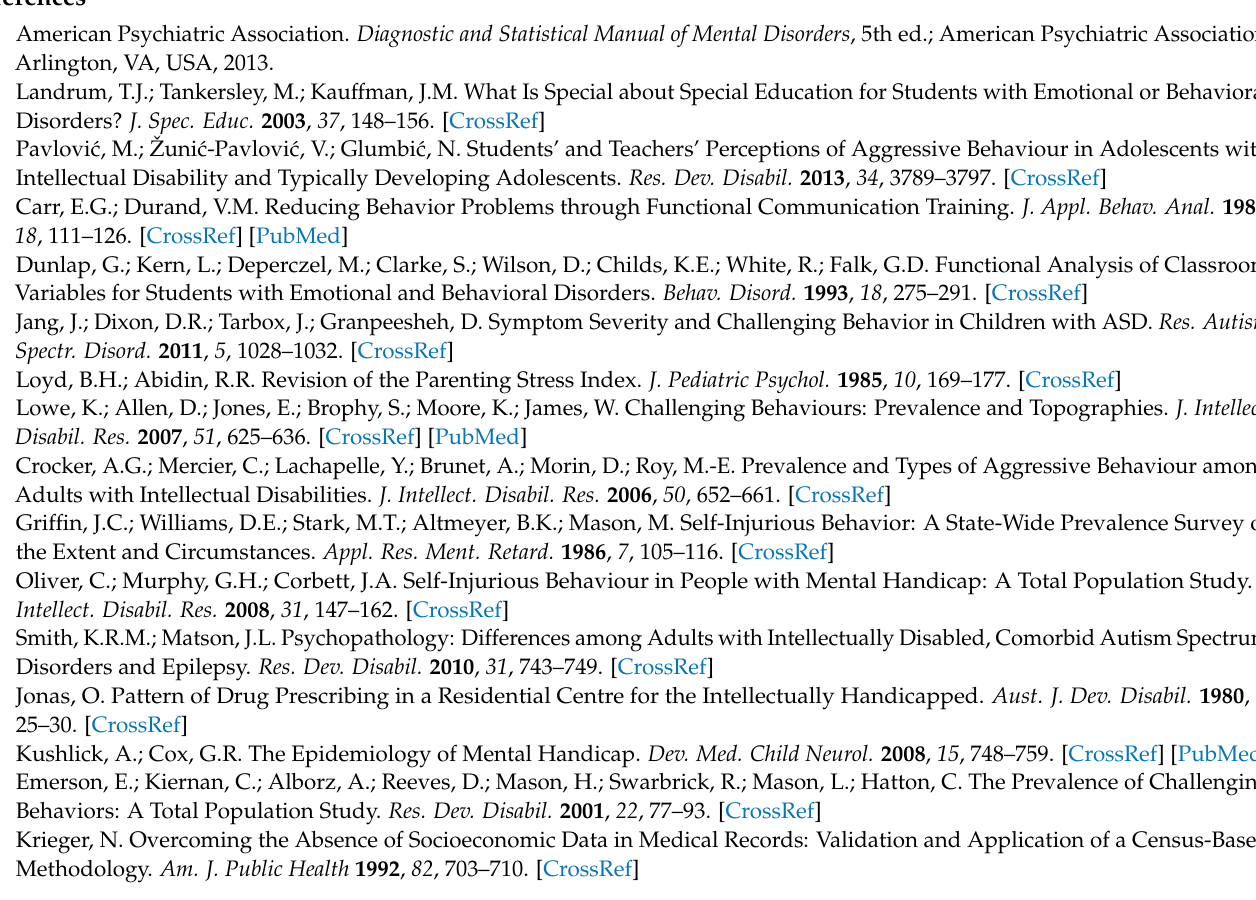
Figure A1. Explanatory diagram of the pictorial concurrent operant preference assessment proce- dure.